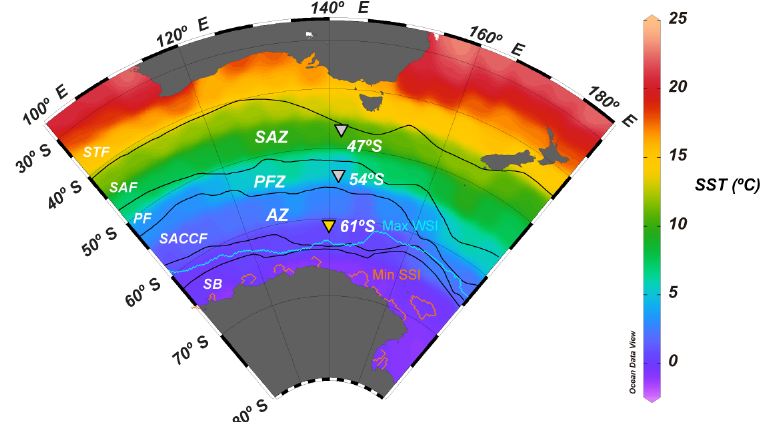
Figure 1. Annual mean sea surface temperature map (World Ocean Atlas; Locarnini et al., 2013) of the Australian sector of the Southern Ocean, showing the position of the main frontal and zonal systems (adapted from Orsi et al., 1995) and the location of the 61, 54 and 47 ◦ S sediment trap stations (inverted triangles). Abbreviations: STF – subtropical front, SAZ – Subantarctic zone, SAF – Subantarctic Front, PFZ – Polar Frontal Zone, PF – Polar Front, AZ – Antarctic zone, SACCF – Southern Antarctic Circumpolar Current Front, SB – southern boundary, Max WSI – maximum winter sea ice extent (August 2001) and Min SSI – minimum summer sea ice extent (February 2002; Fetterer et al.,